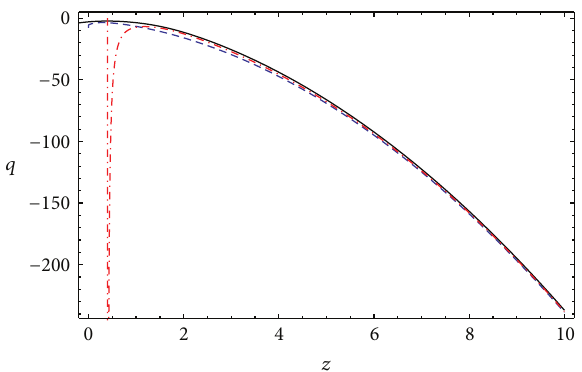
Figure 10: Evolution of deceleration parameter 𝑞 in quintessence model for Ω 𝑚0 = 0.315 and 𝐻 0 = 67.3 . This plot shows that 𝑞 < −1 in the evolution of quintessence model which favors the accelerated expansion of the